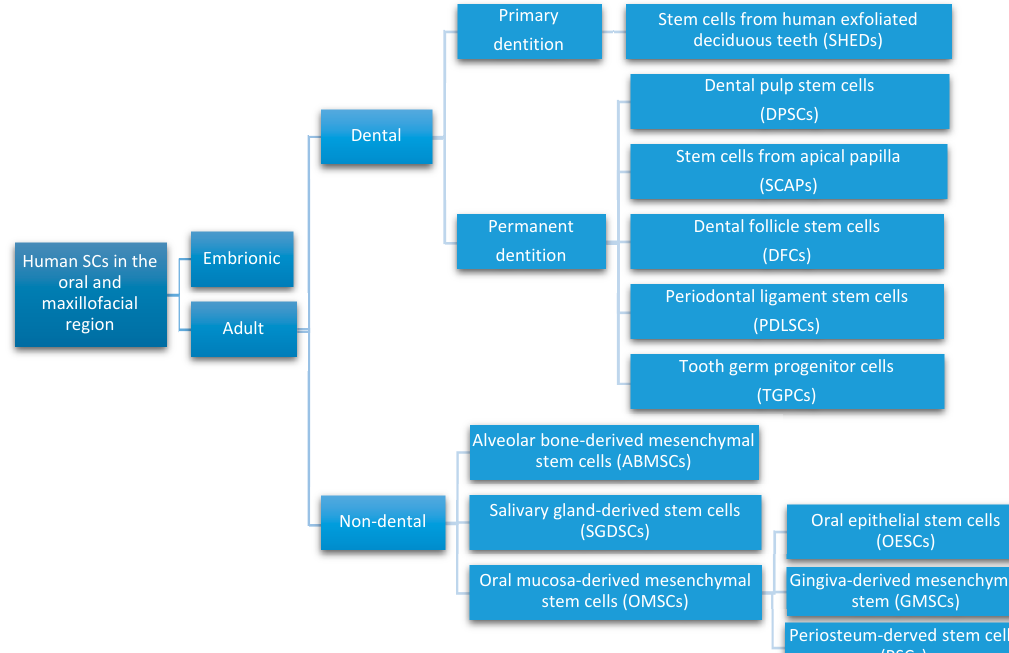
Figure 2. Types of human SCs in the oral and maxillofacial region.